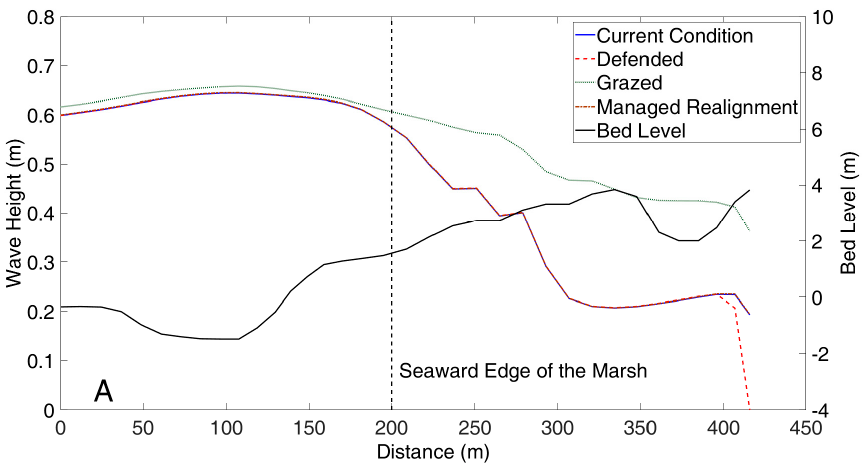
Figure 18. Comparison of peak ebb current magnitude during the 1:50 year easterly storm. ( a ) Current condition, ( b ) difference between defended and current condition, ( c ) difference between grazed and current condition, and ( d ) difference between managed realignment and current condition.